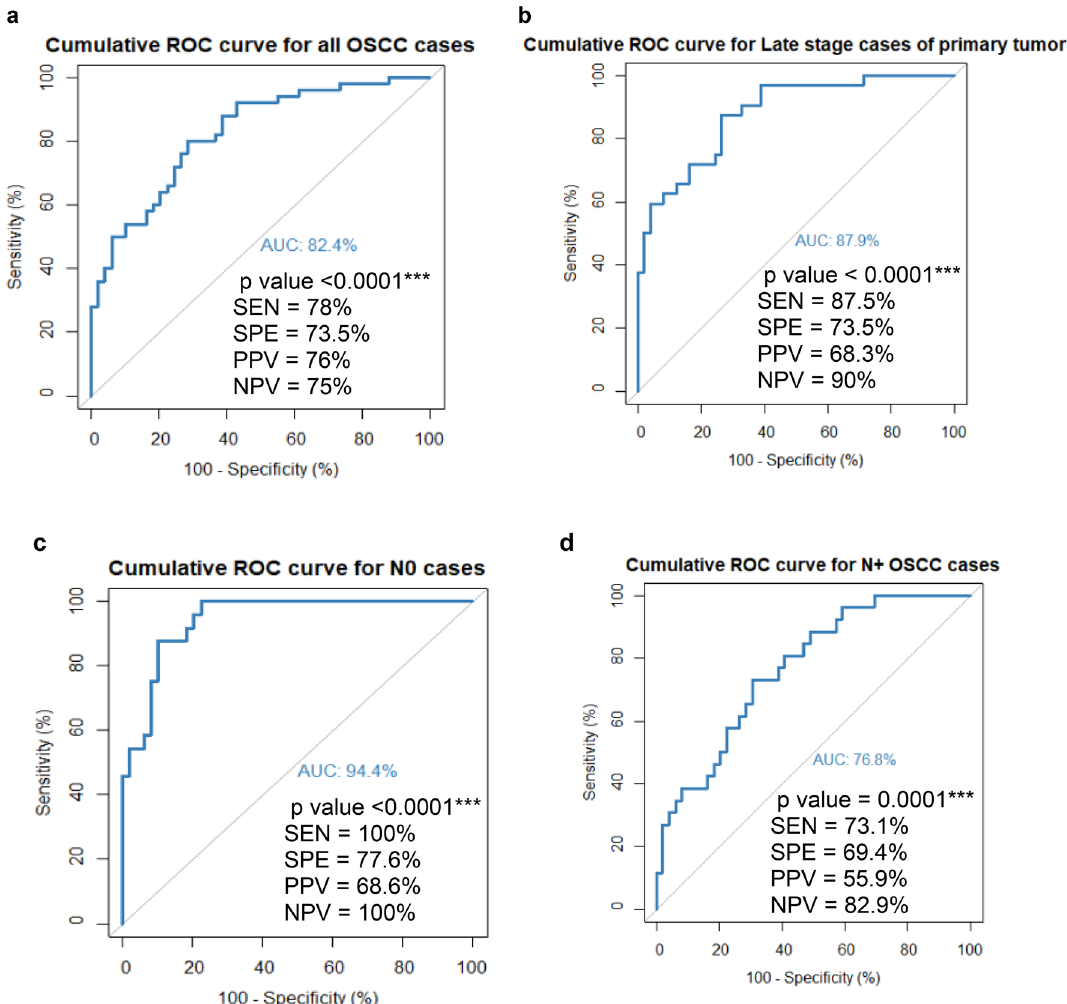
Figure 6. Cumulative ROC curve for the risk prediction models. ( a ) ROC curve for all the cases and controls for the model formed with the proteins AHSG, KRT6C and AZGP1 ( b ) ROC curve for the cases of late stage of primary tumour (T3/T4) and controls for the model formed with the proteins AHSG, KRT6C and AZGP1 ( c ) ROC curve for the cases with N0 stage and controls for the model formed with the proteins AHSG, KRT6C, AZGP1 and BPIFB2 ( d ) ROC curve for the cases with N+ stage and controls for the model formed with the proteins KRT6C and AZGP1. The characteristics of the ROC curve are mentioned in the inset of each figure. AUC area under the curve, SEN sensitivity, SPE specificity, PPV positive predictive value and NPV negative predictive